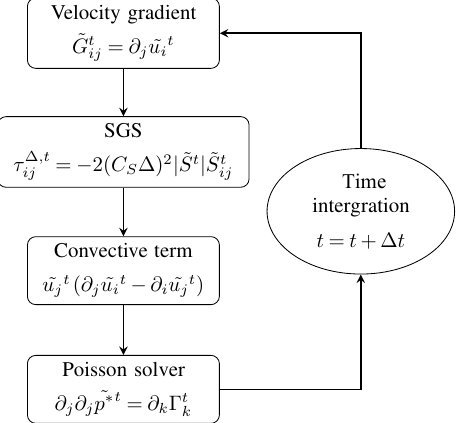
Figure 3. Simplified flowchart of the main algorithm presenting the four modules that represent the bulk of the computational cost.